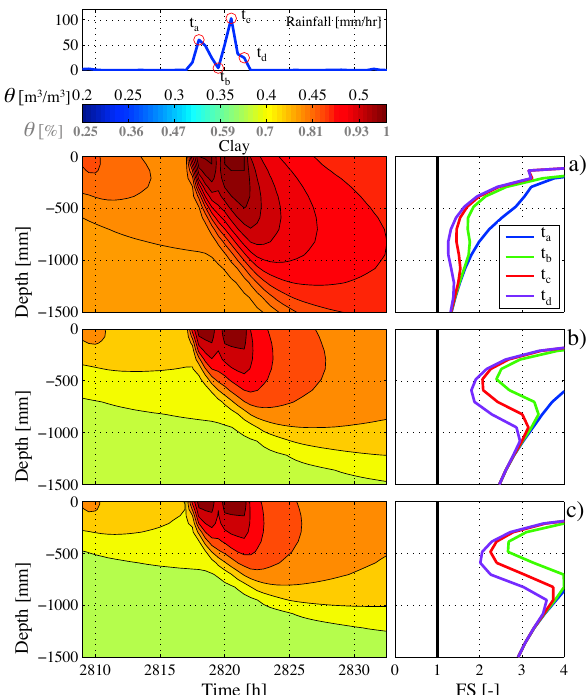
Fig. 6. Temporal evolution at element scale of soil moisture and FS dynamics for a clay element with slope 56 ◦ , for anisotropy values equal to 1 (a) , 300 (b) and 500 (c)